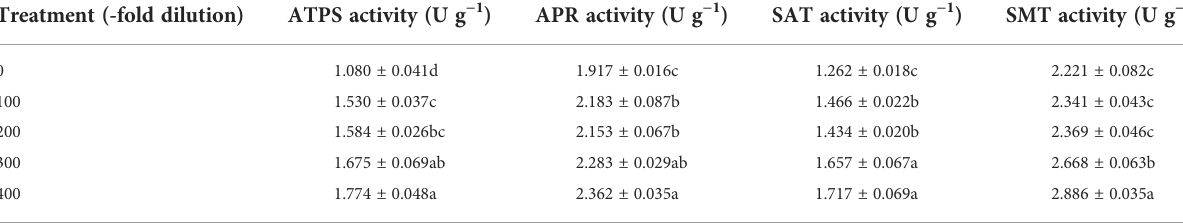
Values are means ± SD of three replicates. Different lowercase letters indicate signi fi cant differences among the treatments (Duncan ’ s Multiple Range Test, P <